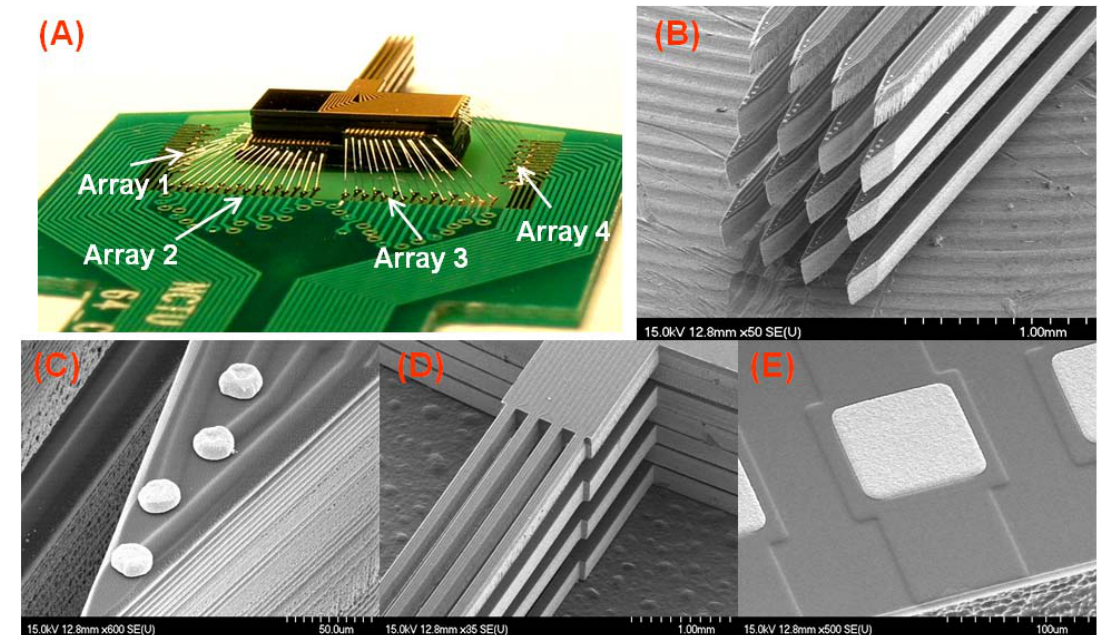
Figure 4. The photographs of successfully assembled 3-D microprobe array. (A) The wire-bonded result of 3-D microprobe array. Four different bonding levels were